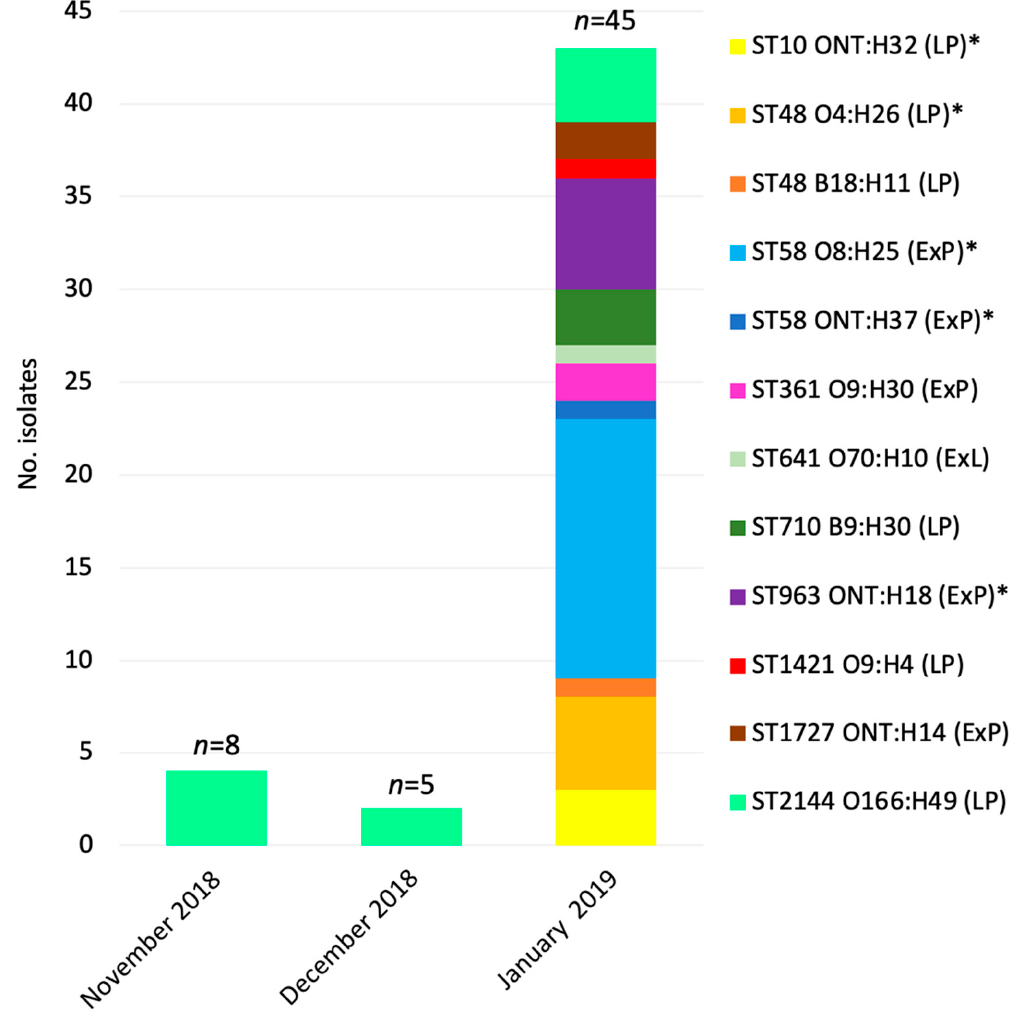
Figure 2. Amoxicillin-resistant E. coli strain types detected in faecal samples from orphaned, aban- doned, and heat-stress-affected grey-headed flying fox pups entering care in South Australia during the 2018/2019 pup season. Numbers ( n ) above the bars indicate the number of faecal samples cul- tured. ExP, ExPEC-potential; ExL, ExPEC-like; LP, low pathogenicity. Asterisks (*) indicate multi- drug-resistant strains.